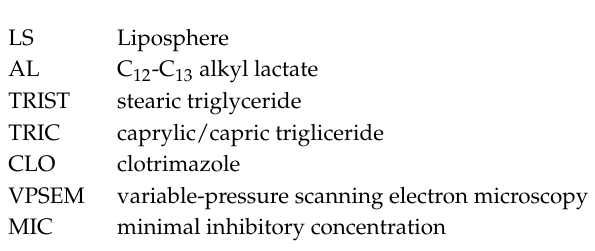
Figure S1: Variable pressure scanning electron microscopy images of LS TRIST -CLO (A) and LS TRIST/AL1 -CLO (B), Figure S2: Comparison of the theoretical (x) and experimental CLO profiles from LS TRIST -CLO (A), LS TRIST/AL1 -CLO, (B), Gel LS TRIST -CLO (C) and Gel LS TRIST /AL1 -CLO (D), The theoretical curves were obtained using the coefficient calculated by linear regression of the linearized form of Equation (4) ( (cid:3) ) and Equation (5) (